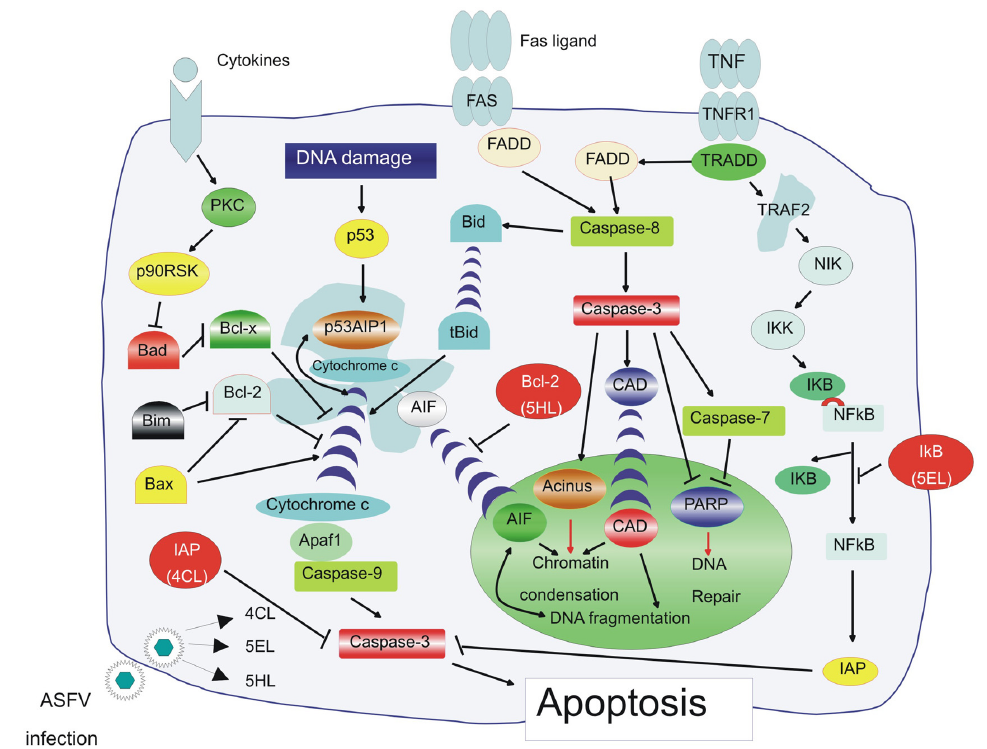
FIGURE 1. Viral-induced apoptosis in African swine fever virus infected